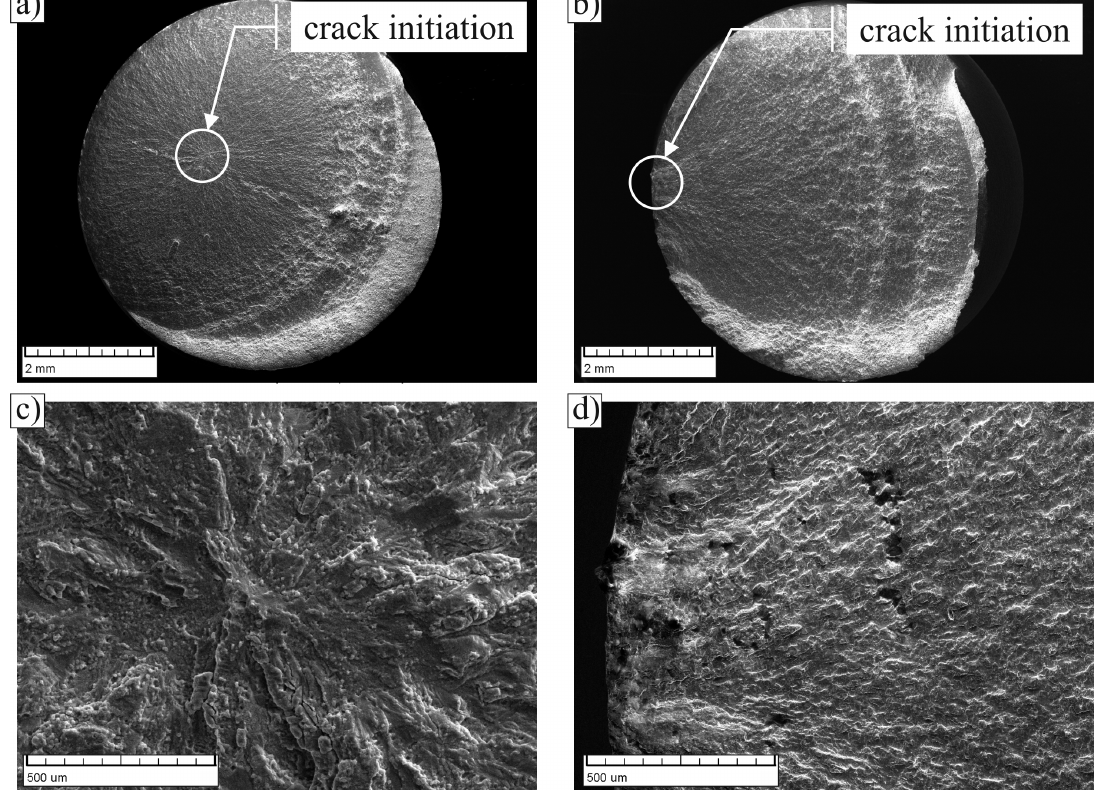
Figure 12. Fracture surfaces of specimen deep rolled at room temperature and cryogenic temperature fatigued at a cyclic loading amplitude of 480MPa. Overview images of conditions deep rolled at room ( a ) and cryogenic ( b ) temperature using a deep rolling force of 855N are depicted with encircled crack initiation spots. High resolution micrographs depicting the microstructural features being responsible for crack initiation are shown in ( c + d ).